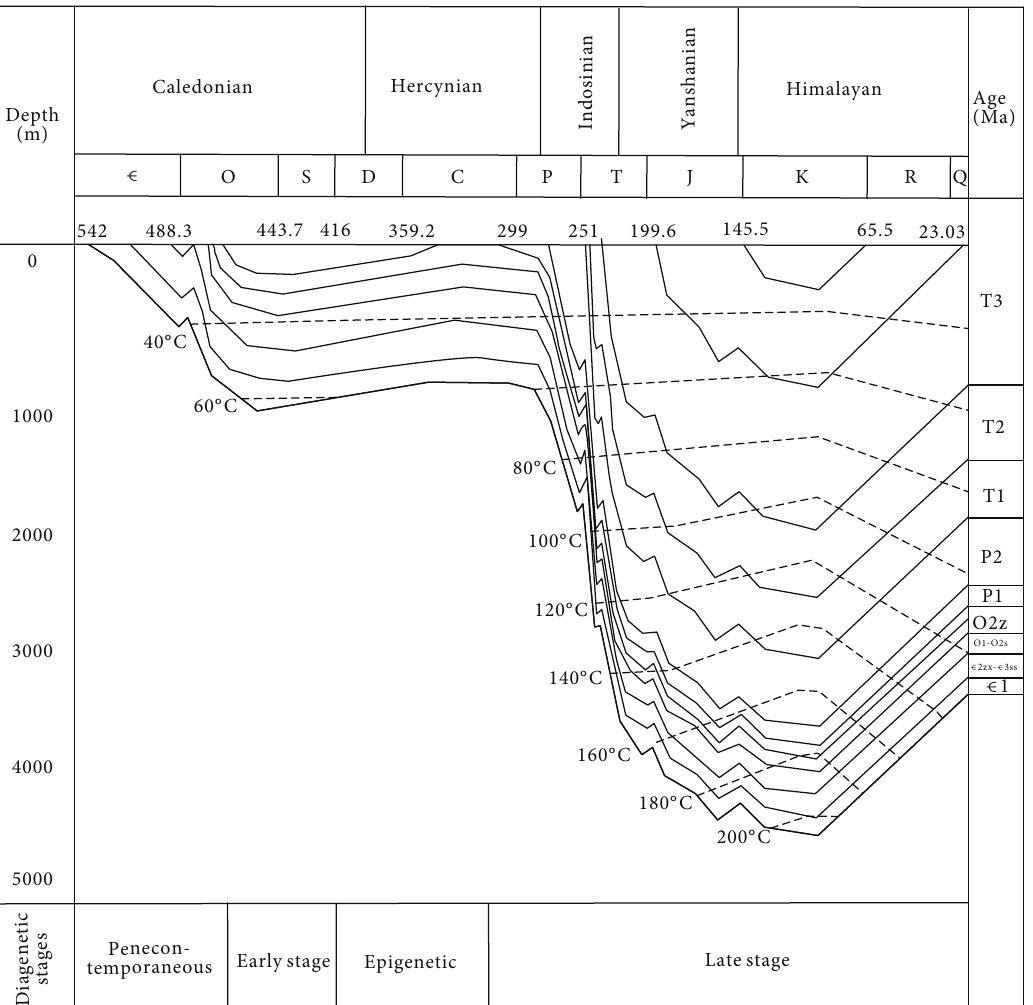
Figure 9: Reservoir burial history — diagenesis history of M5